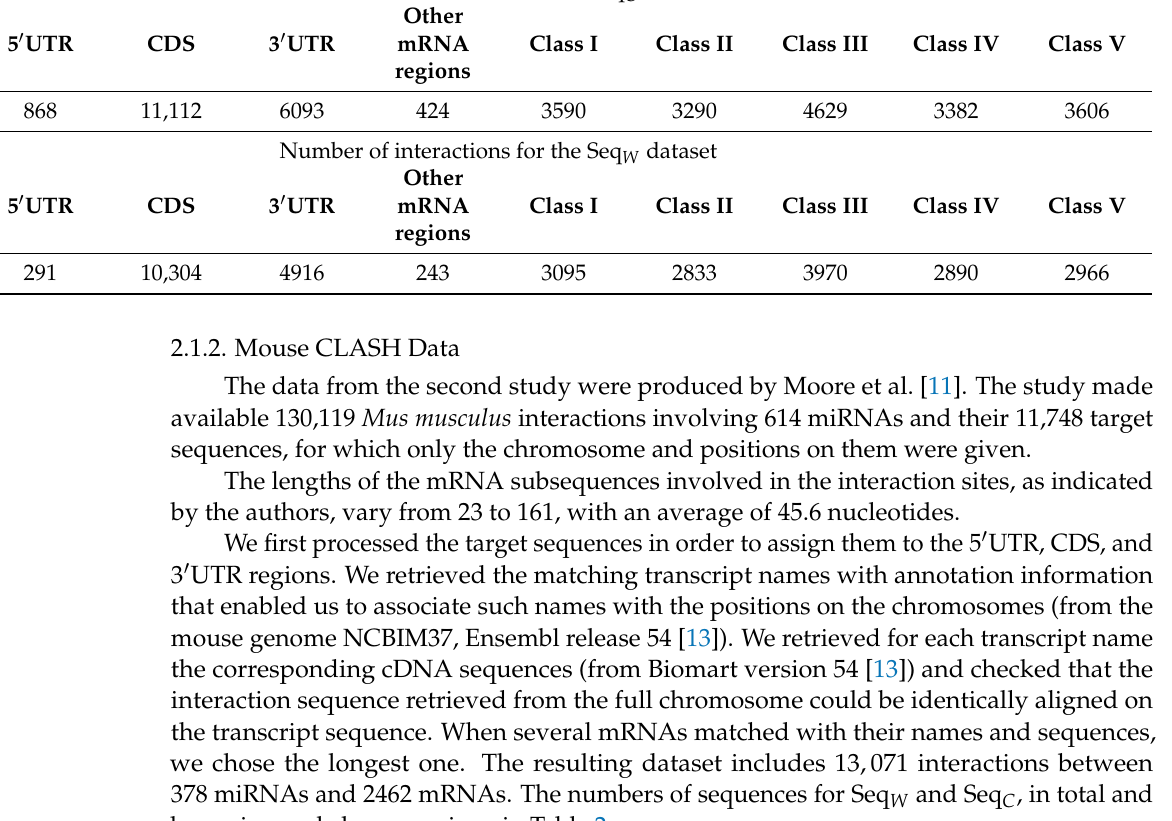
Figure 1. Representation of the classes as defined in the human [10] (I, II, III, IV and V) and in the mouse [11] (1, 2, 3, 4, 5, and 6) studies. Table 1. Number of interactions for each human dataset, in total and by region and class. Number of interactions for the Seq C